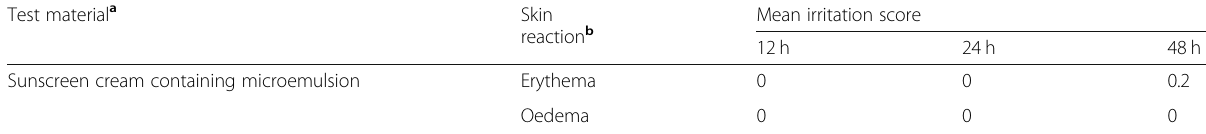
Table 4 Skin irritation study data Test material